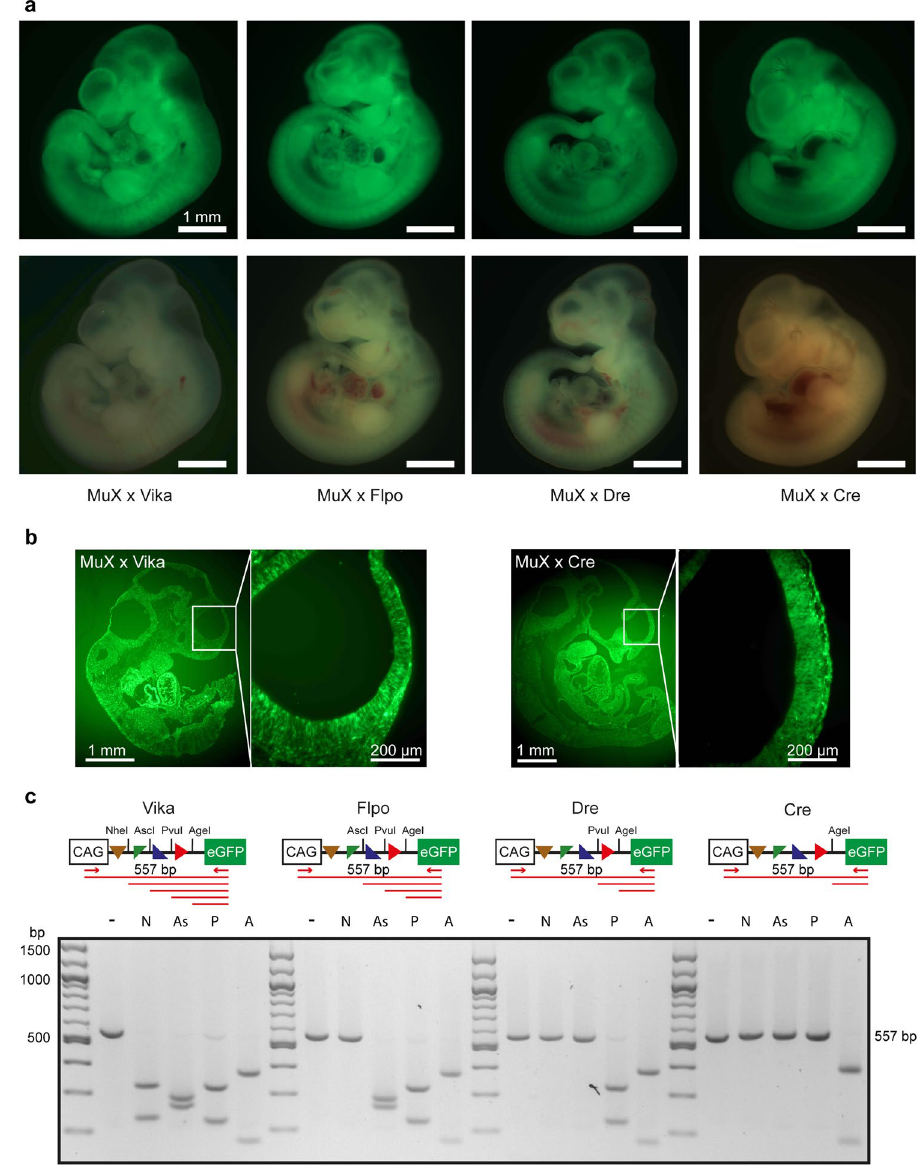
Figure 3. The MuX reporter is functional in mice. ( a ) Micrographs showing embryos at E10.5 isolated from intercrosses between Vika, Flpo, Dre and Cre deleter male mice with Rosa26-VFRL-eGFP (MuX) reporter mice. The reporter protein is ubiquitously expressed. Scale bar = 1 mm. ( b ) Sections of E10.5 embryos. ( c ) PCR product from each of the four deleter x MuX reporter crosses followed by digestion with indicated restriction endonucleases ( − = undigested, N = NheI, As = AscI, P = PvuI, A =